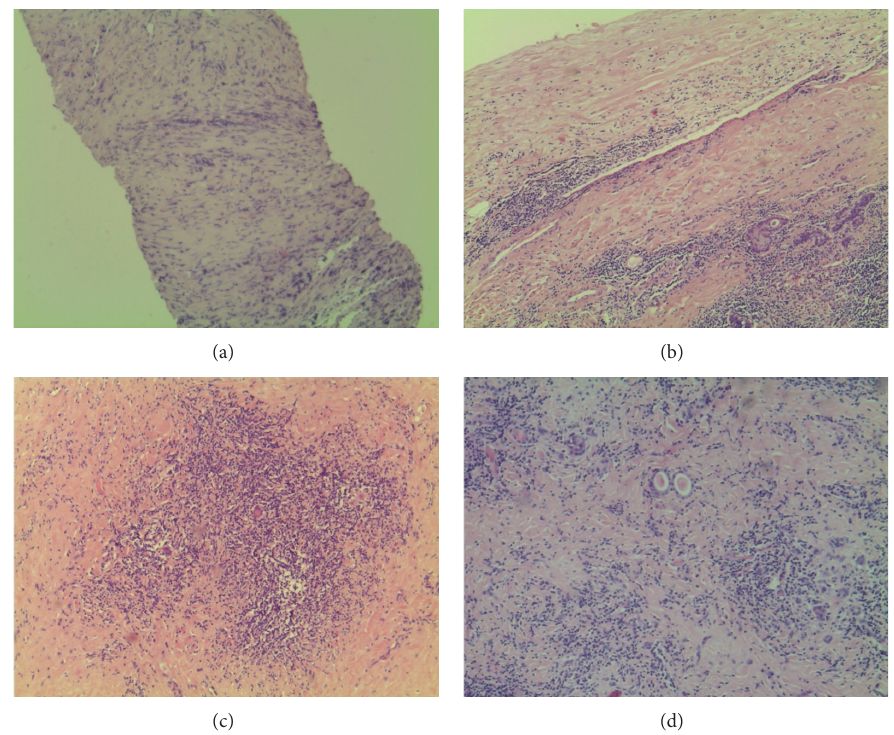
Figure 3: (a) H&E staining (4x): fine needle thyroid biopsy contained an admixture of diffuse chronic lymphocytic infiltration and dense fibrous tissue with a total absence of thyroid follicles. (b) H&E staining (20x): thyroid gland with capsule easily dissociable from the periglandular tissues and follicular cells in squamous metaplasia; (c),(d) H&E staining (20x): thyroid tissue with residual follicles immersed in dense fibrotic stroma and surrounded by diffuse chronic lymphocytic